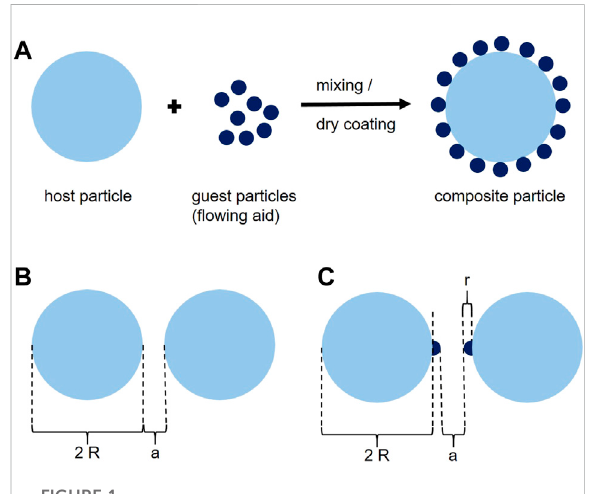
FIGURE 1 (A) formationofcompositeparticlesbydryparticlecoatingof host particles with nanoscale guest particles, (B) geometry for description of vdW interactions between two spheres of identical size according to Eq. 1, (C) geometry for description of vdW interactions between two spheres with asperity or radius of curvature according to Eq. 2 (Rumpf,